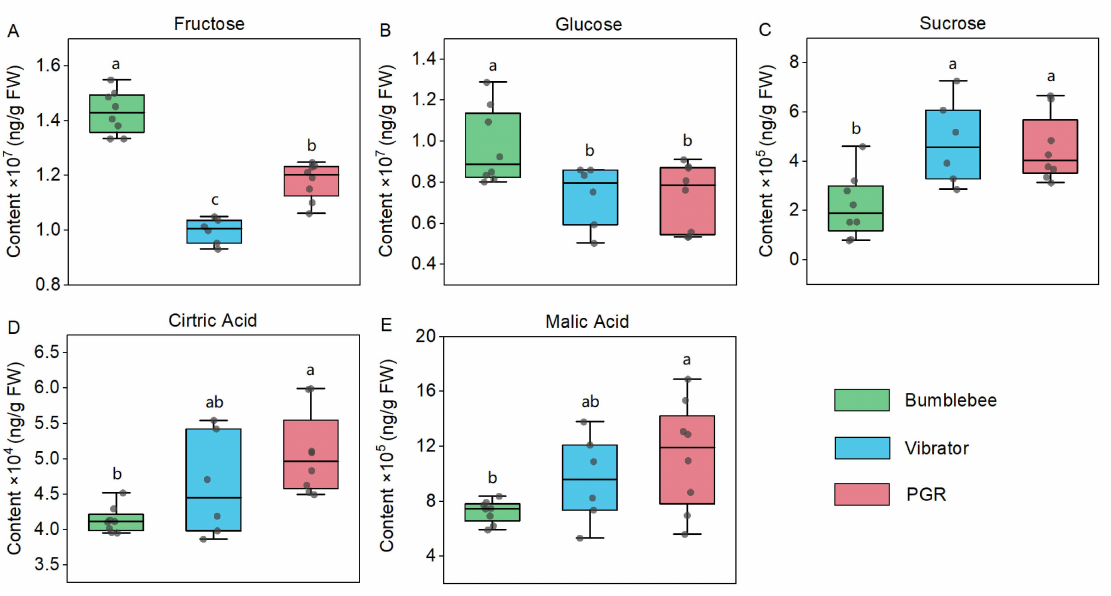
Figure 5. The content of fructose ( A ), glucose ( B ), sucrose ( C ), citric acid ( D ), and malic acid ( E ) in tomato fruit by different pollination treatments. A total of 66 tomato fruits were collected and each of three tomato fruits grouped into one biological replicate. Eight replicates were analyzed in treatments of ‘bumblebee’ and ‘PGR (plant growth regulator)’, and six replicates were analyzed in treatment of ‘vibrator’. Boxes indicate quartiles with the median marked as a horizontal line. General linear models followed by Duncan post-hoc method were used to compare the content of fructose, glucose, and sucrose, and non-parametric Kruskal–Wallis one-way ANOVA followed by the Dunn–Bonferroni post-hoc method was used to compare the content of citric acid and malic acid by different pollination treatments. Different letters indicate significant differences at α = 0.05. ‘FW’ indicates fresh